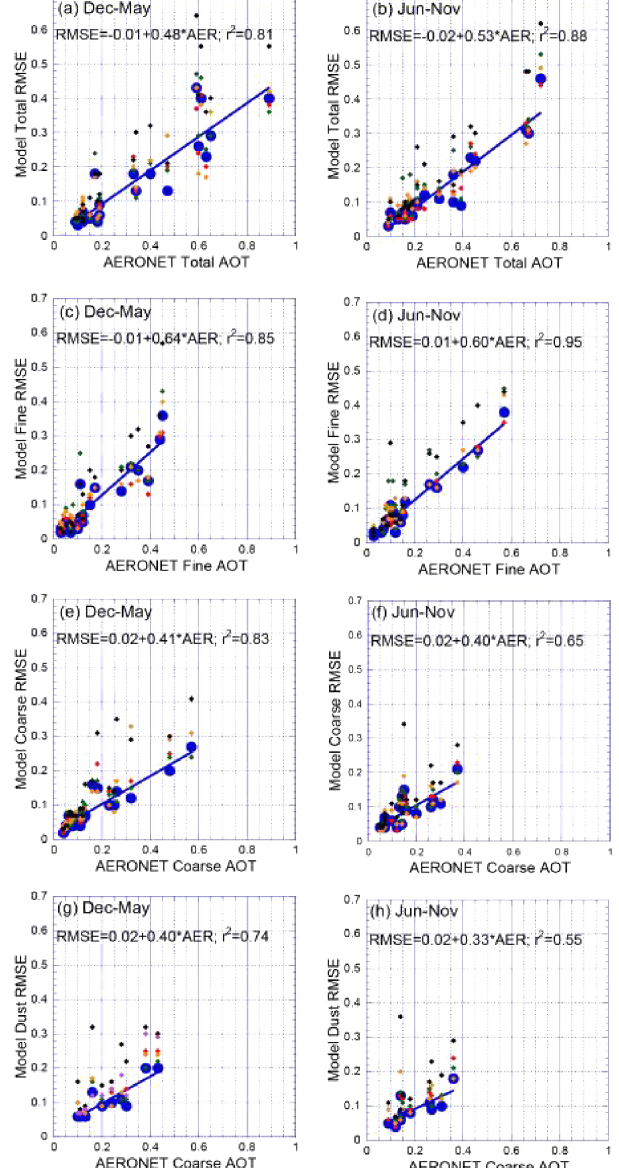
Figure 7. Bi-seasonal comparisons of + 1-day model 550nmAOT RMSE with 21 core AERONET verification sites listed in Table 1. Large blue circles are ICAP-MME means. Other models are small colored diamonds. Data is stratified (left column) for December– May 2011, (right column) June–November. (a) and (b) core models and ensemble mean comparisons to total AERONET derived 550 nm AOT. (c) and (d) models vs. AERONET for fine mode parti- cles. (e) and (f) models vs. AERONET for coarse mode particles. (g) and (h) model dust vs. AERONET coarse for dust stations listed in Table 2. NGAC is included in the dust comparison.